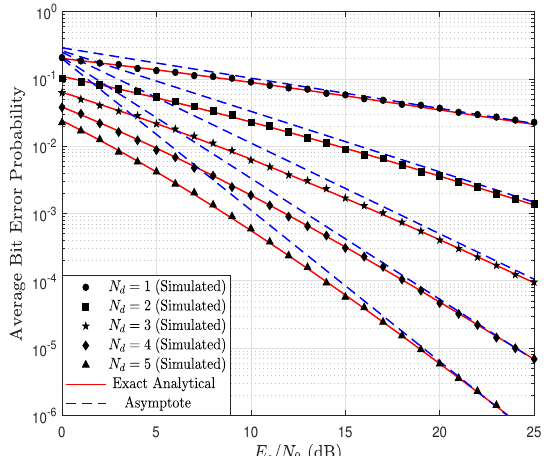
Figure 8. ABEP as a function of E s / N 0 , parameterized by N d considering N r = 5, k r = 1.5, k d = 0.9, λ r = 1.4, λ d = 1, and a =